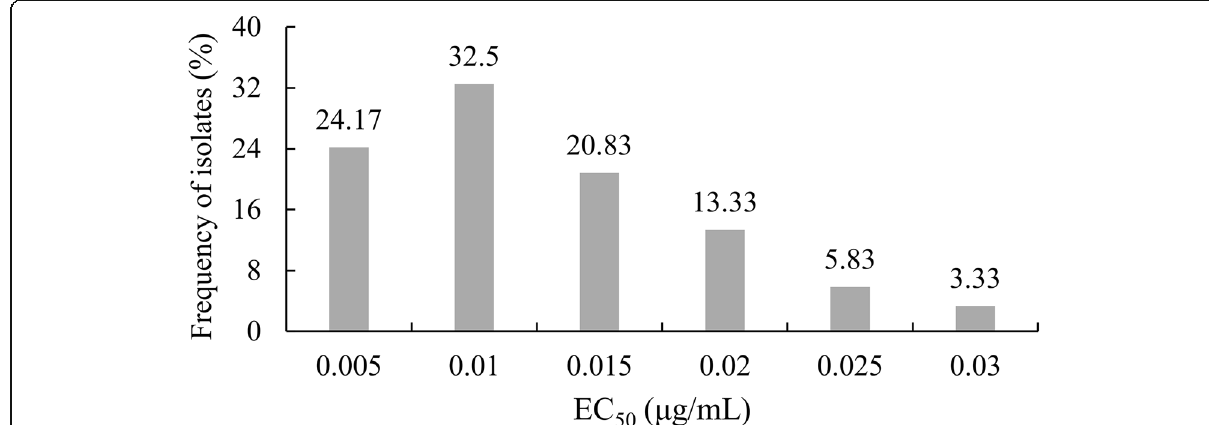
Fig. 1 Frequency distribution of the effective concentrations of pyraclostrobin for 50% inhibition of mycelial growth (EC 50 ) of Valsa mali . In total, 120 V. mali isolates were collected from apple orchards with no history of pyraclostrob application in China. Values on the bar show frequencies of isolates with corresponding EC 50 values